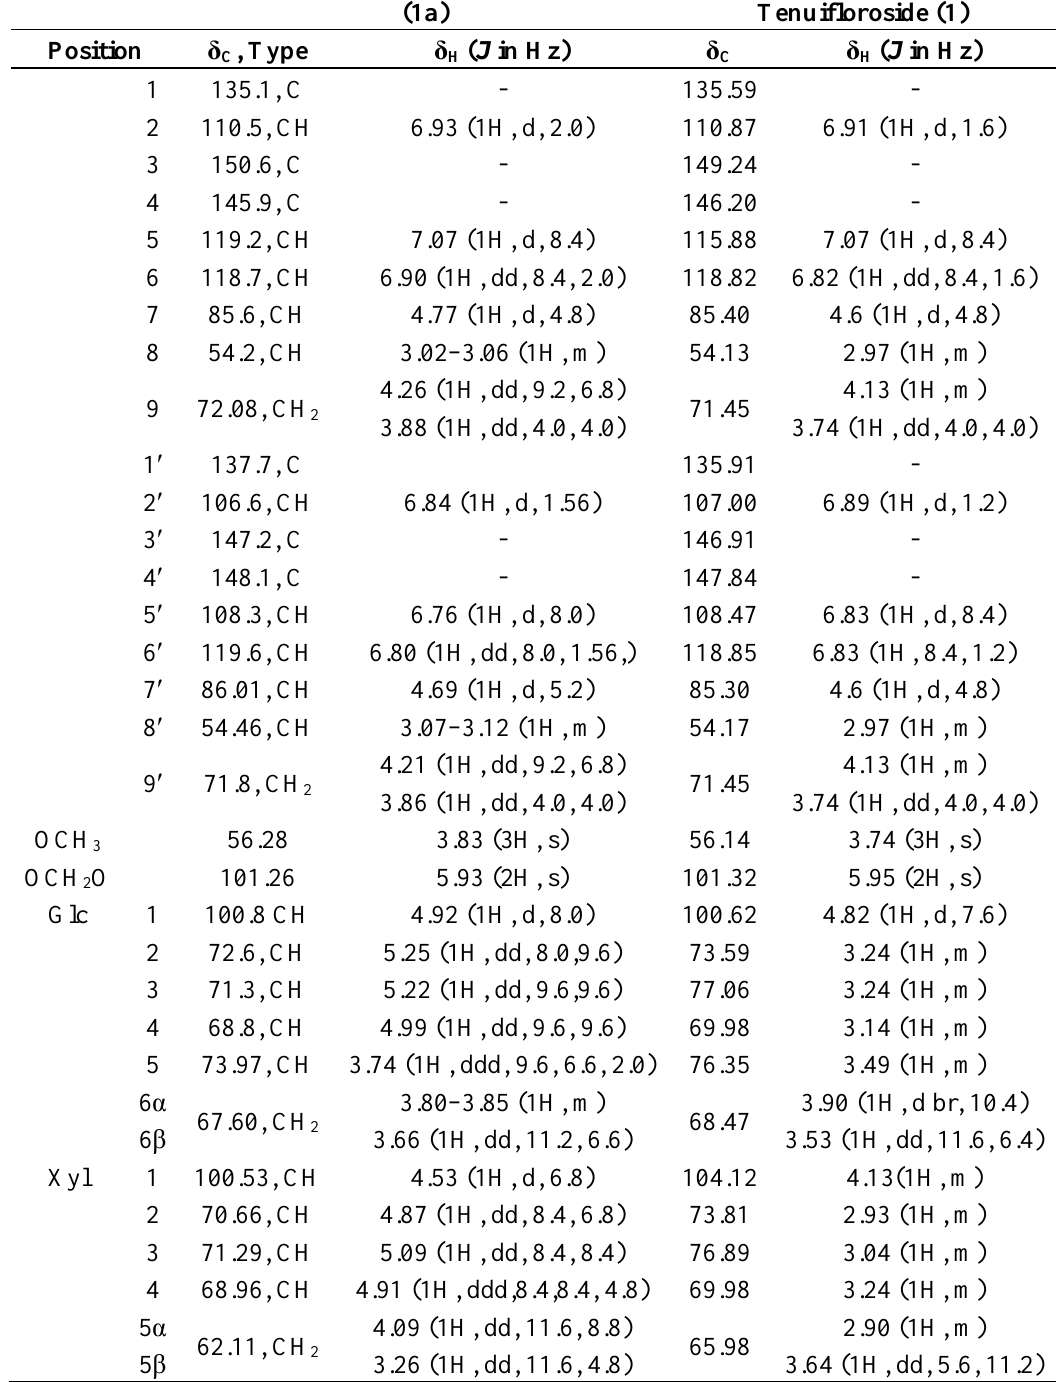
Table 1. 1 H (400 MHz) and 13 C (100 MHz) NMR data for compounds 1 (DMSO- d 6 ) and 1a (CDCl 3